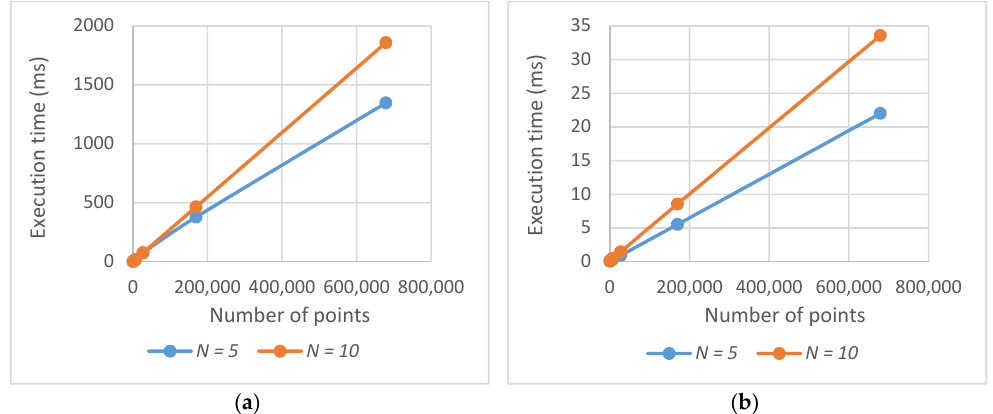
Figure 9. Dependence of the execution time on the number of points: ( a ) original algorithm; ( b ) optimized algorithm.